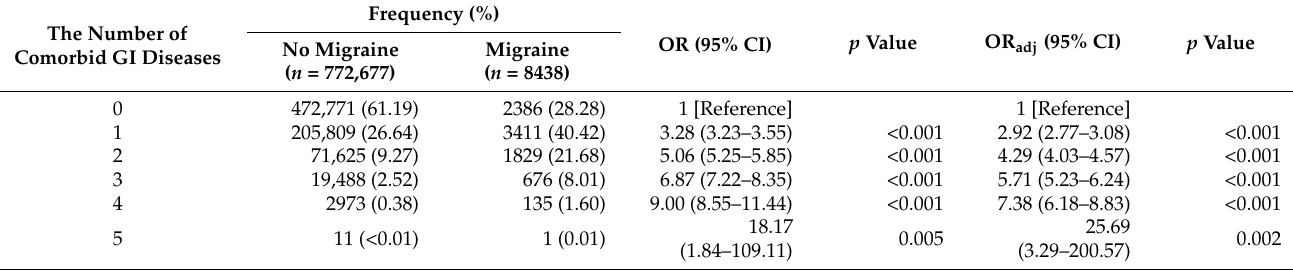
Table 3. The association between migraine and the number of comorbid GI